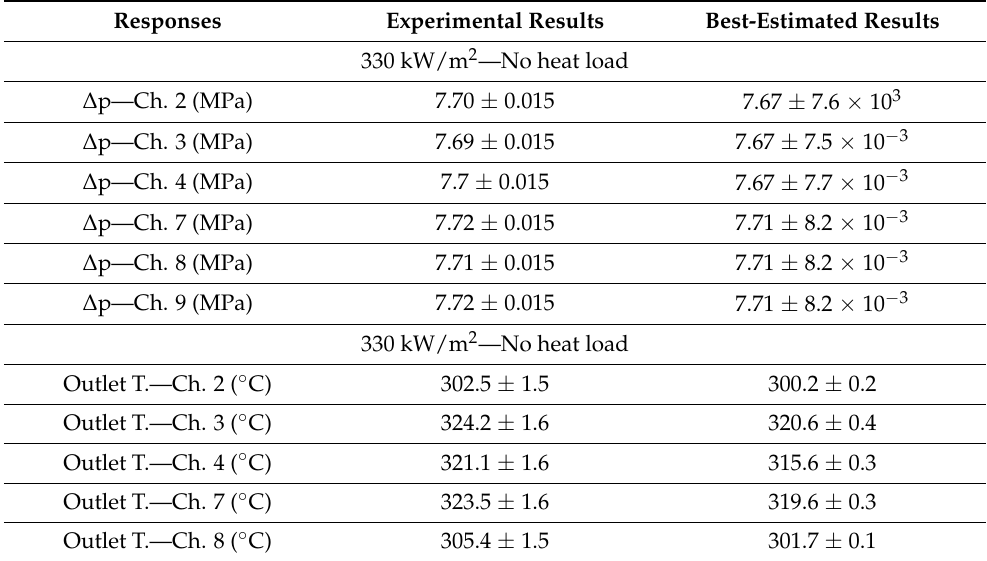
Table 2. Results of the pre-calibration at the 330 kW/m 2 steady-states (with and without heat flow).